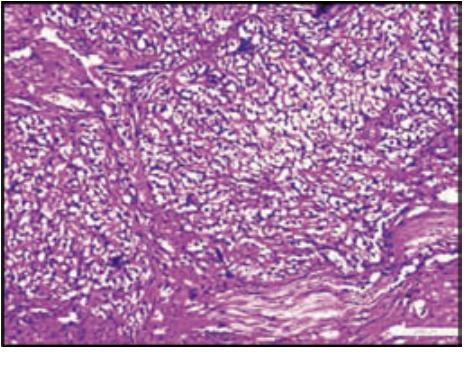
Fig.7. Lipid rich carcinoma - numerous small vacuoles or a single large vacuole (H&Ex200)